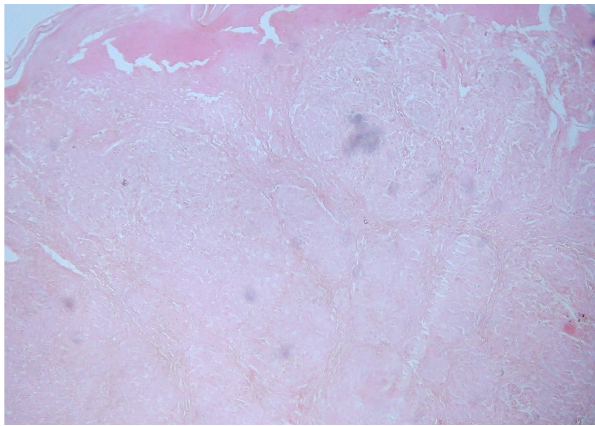
Figure 2: Photomicrograph showing multiple well formed epitheli- oid cell granuloma without caseation necrosis (HE stain; X50).